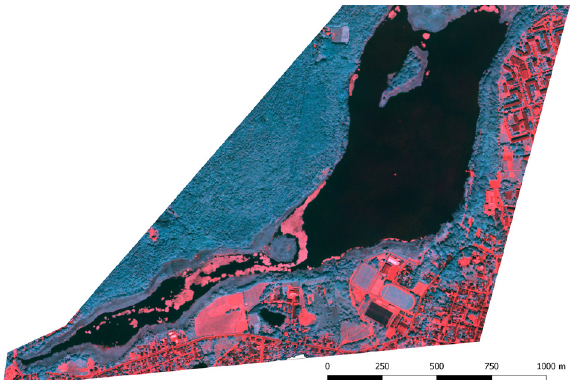
Fig. 11. A picture of the Lake Swarzędzkie in near infrared to establish the course of the shoreline and the surface of the basin (prepared by